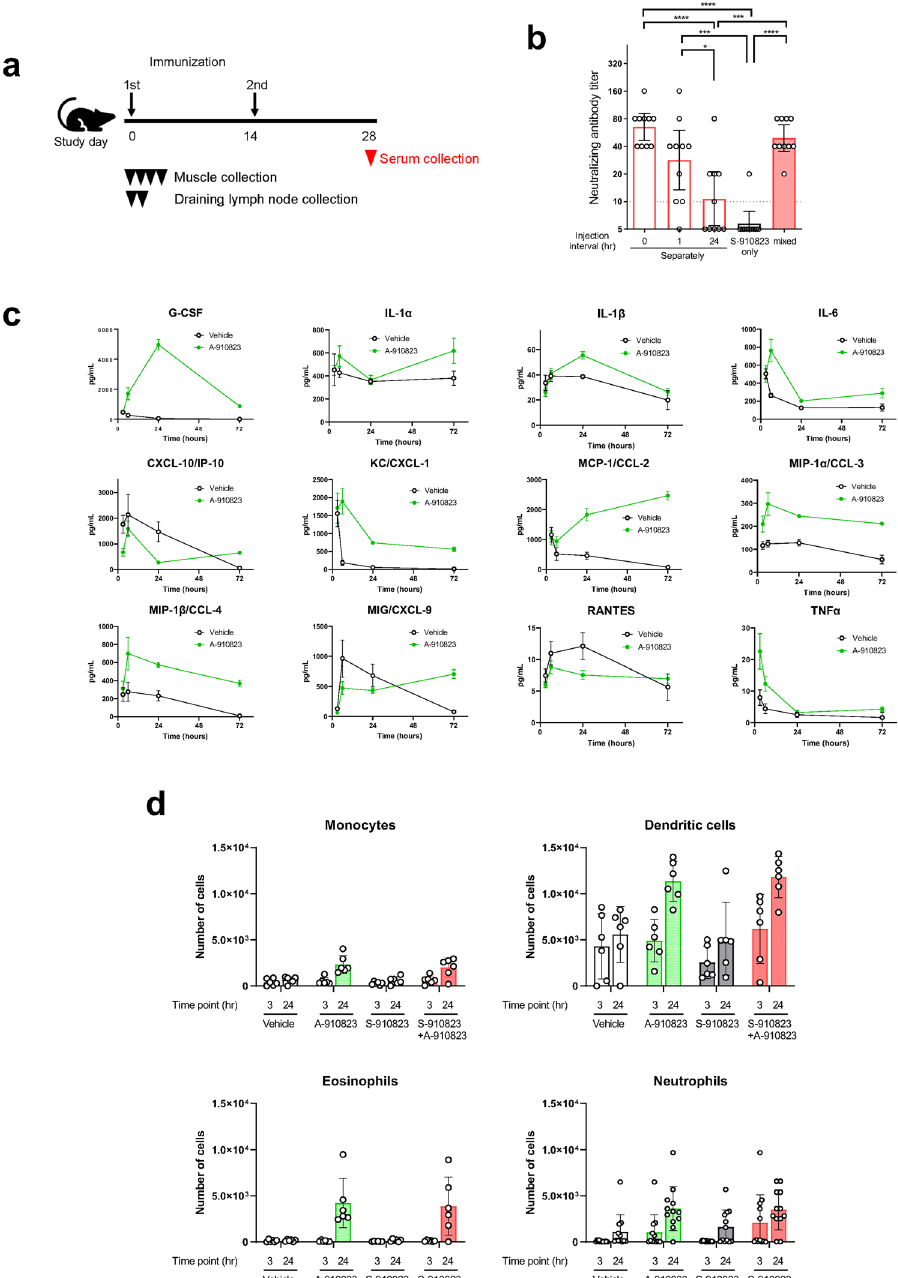
Figure 4. Effect of A-910823 on S-910823 immunogenicity. ( a ) Study schedule schematic. ( b ) Physical association of S-910823 with A-910823 in mice. S-910823 (1 μg) and A-910823 (100% v/v) were separately administered into mice at different injection intervals (0 h, 1 h, and 24 h) on Day 0 and Day 14 (n = 10/ group). Serum titers of neutralizing antibodies against authentic SARS-CoV-2 virus were measured in mice at 2 wk post-second immunization. Each bar represents the geometric mean titer (error bars indicate a 95% confidence interval). The circles represent the results of individual animals. The dashed line indicates the lower limit of detection. Statistical significance was determined using one-way analysis of variance, followed by Tukey’s multiple comparison test (* P < 0.05, *** P < 0.001, and **** P < 0.0001). ( c ) Cytokine and chemokine concentrations in the muscle homogenate supernatant at 3 h, 6 h, 24 h, and 72 h post-administration of 50% (v/v) A-910823 or vehicle (n = 4–7 per time point). Data are represented as mean ± standard error. ( d ) Quantification of inflammatory cells in the draining lymph nodes at 3 h and 24 h post-administration of vehicle or 1 μg of S-910823 with or without A-910823 (n = 6/group). The bars represent the mean number of cells (error bars indicate standard error of mean). The circles represent the results of individual